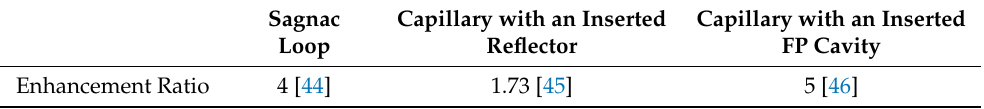
Table 1. Comparison of the enhancement ratios of three different optical path